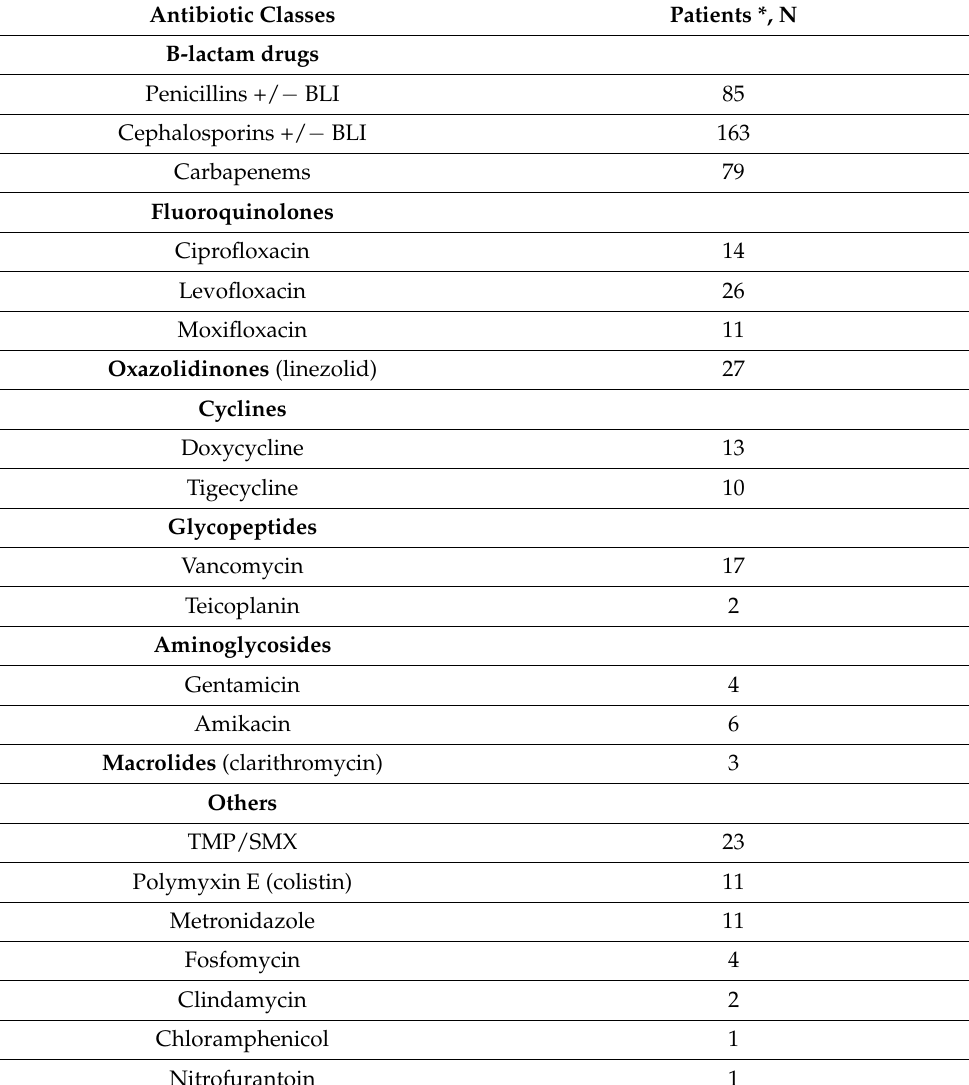
Table 2. Antibiotic